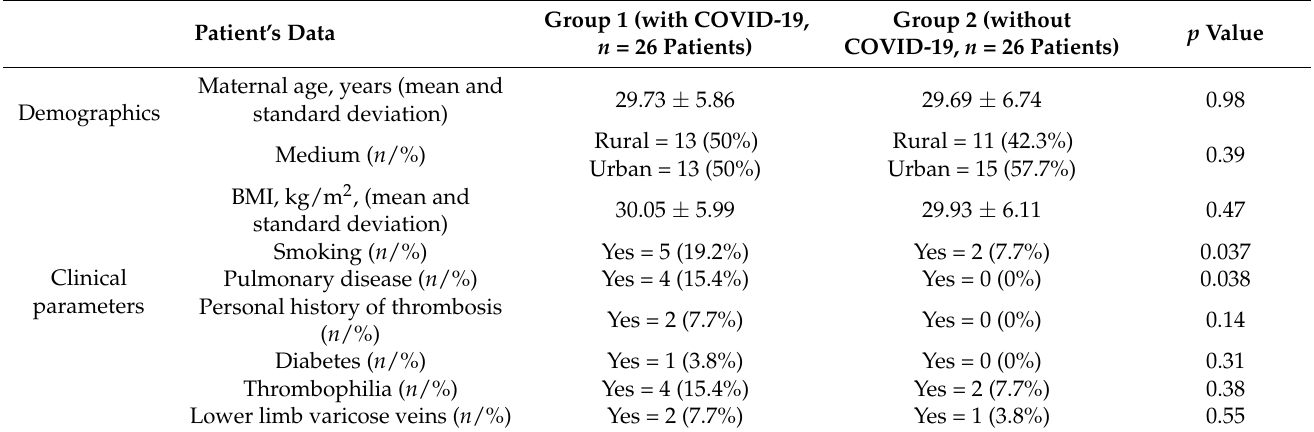
Table legend: BMI—body mass